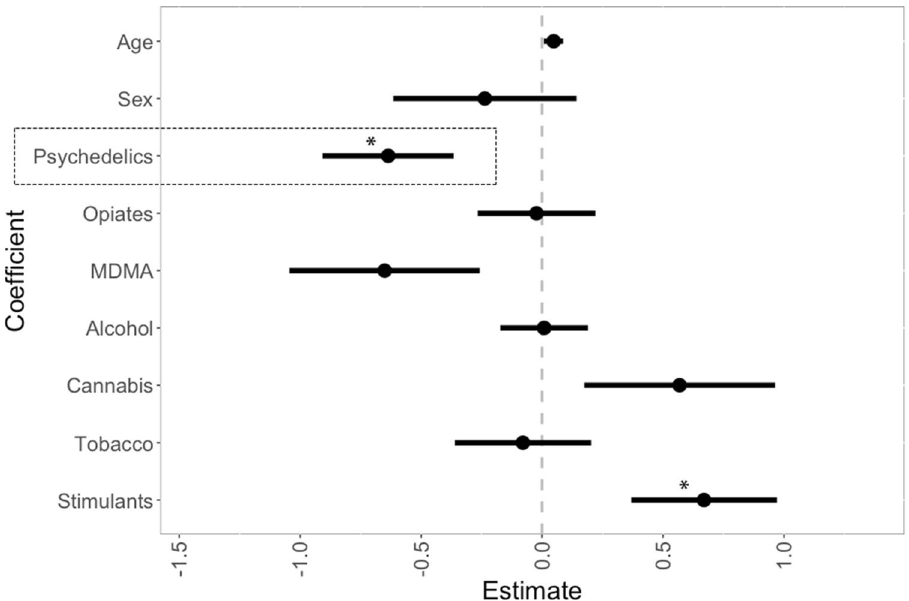
Figure 3. Drug use and evidence integration impairment (EII). Regression coefficient plot of exposure to drugs and demographics as predictors of evidence integration impairment. *p <